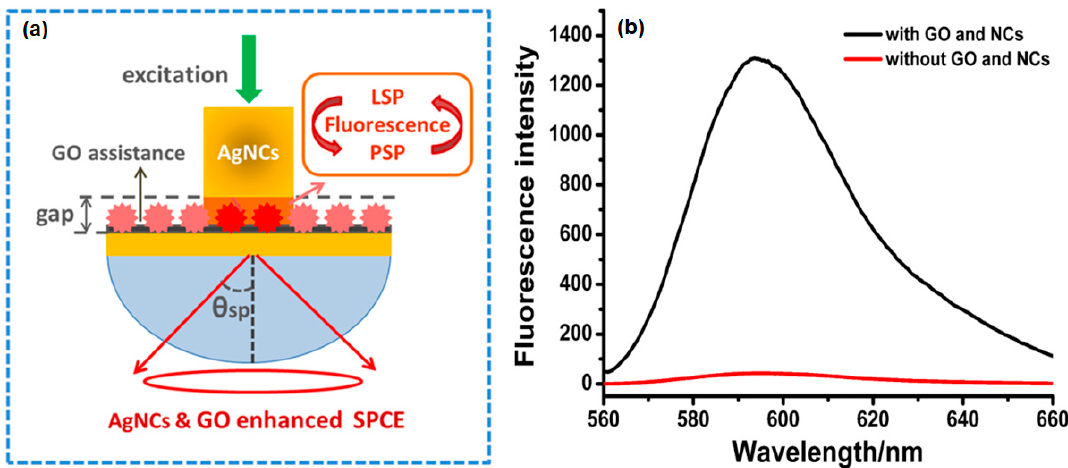
Figure 25. ( a ) AgNCs and GO enhanced SPCE structure. ( b ) The resulting fluorescence spectrum (right) (adapted with permission from Reference [95], copyright Elsevier).